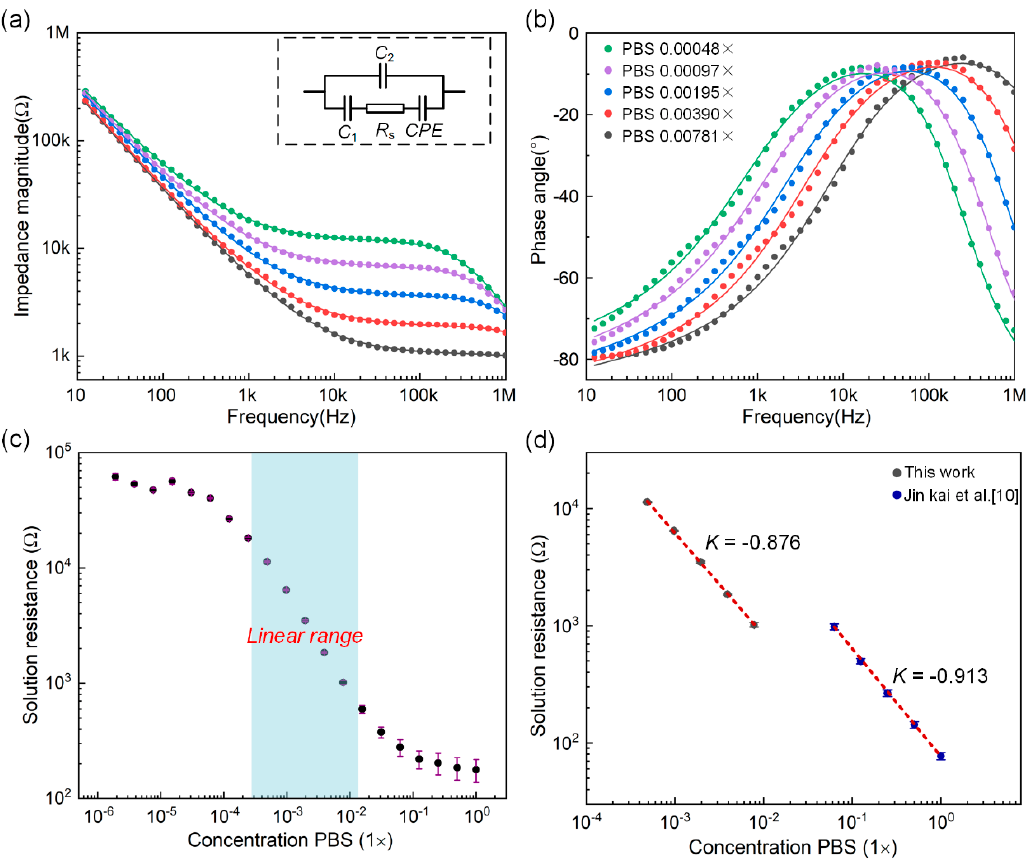
Figure 2. ( a ) and ( b ) show the impedance measurements and fitting values of PBS solutions of five different concentrations within the linear interval; ( c ) the relationship between the equivalent resistance Rs and the concentration; ( d ) compares the relationship between PBS concentration and equivalent resistance with previous work.